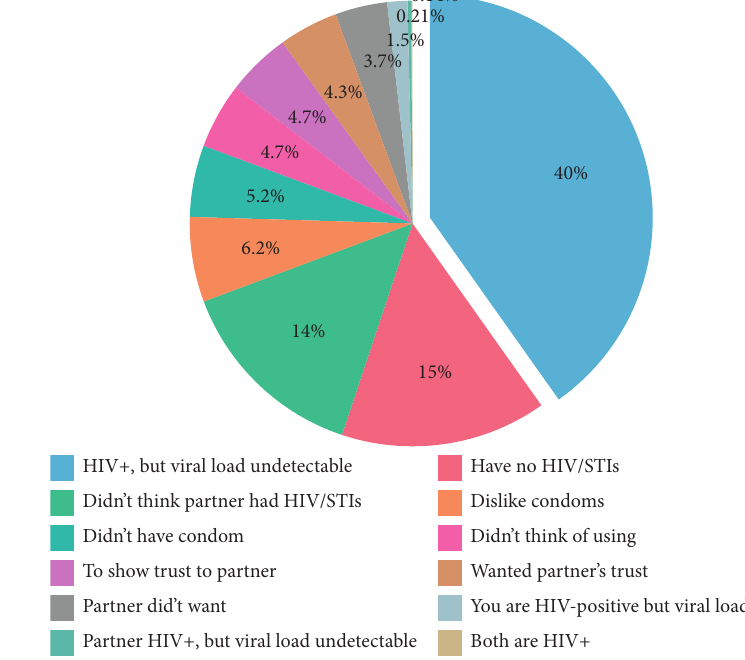
Figure 2: Reasons for not using condoms with the last